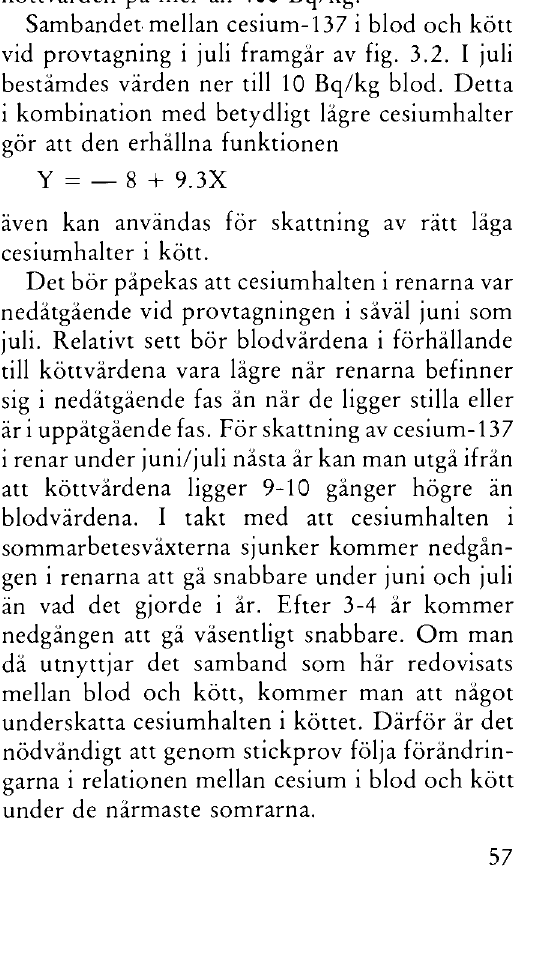
I figur 3.1 illustreras